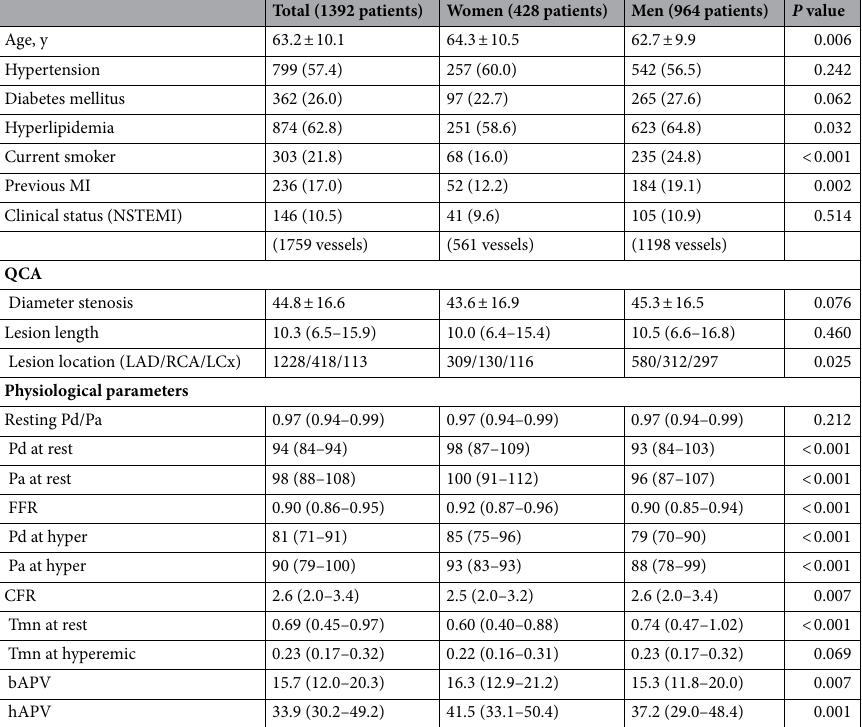
Table 1. Baseline characteristics. Data are presented as n (%) or median (Q1–Q3). MI Myocardial infarction, NSTEMI Non-ST segment elevation myocardial infarction, QCA Quantitative coronary angiography, LAD Left anterior descending artery, RCA Right coronary artery, LCx Left circumflex artery, FFR Fractional flow reserve, CFR Coronary flow reserve, Tmn Mean transit time, APV Average peck flow velocity.